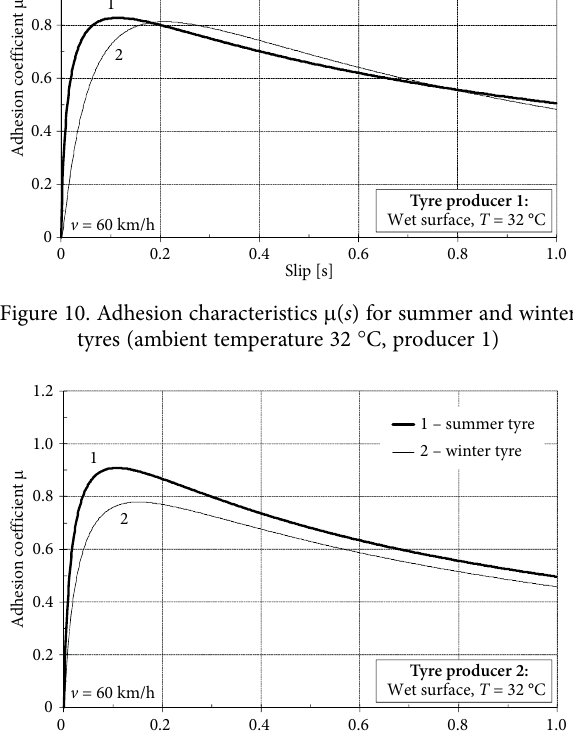
Figure 8. Velocity characteristics m 0 ( v ) for different ambient temperatures